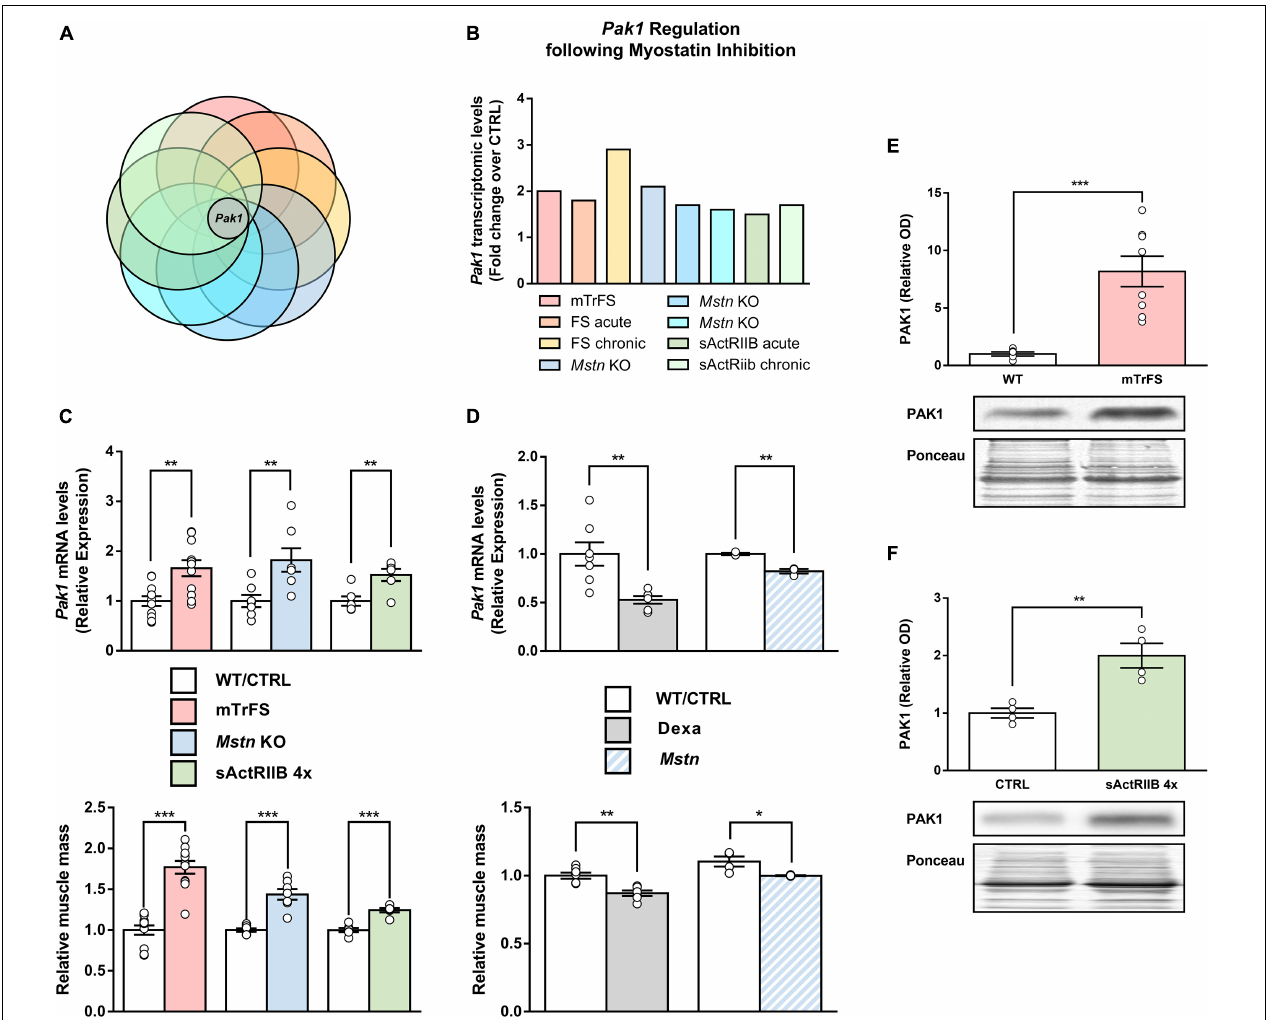
FIGURE 1 | Global comparative transcriptomic analysis of skeletal muscles from mouse models of MSTN inhibition identified Pak1 as a MSTN-responsive gene. (A) Venn diagram comparing the differentially expressed genes into muscles from eight different models of pre- and postnatal MSTN inhibition with Pak1 as the only gene commonly regulated between all the transcriptomes compared. (B) Pak1 mRNA fold-changes for each muscle transcriptome studied. (C) Muscle Pak1 mRNA levels and muscle weight from TA muscles of mTrFS vs. WT mice ( n = 11/group); from TA muscles of four times sActRIIB-injected vs. PBS-injected mice ( n = 6/group) and from GC muscles of MSTN KO vs. WT mice ( n = 7/group). (D) Muscle Pak1 mRNA levels and muscle weight from GC muscles of DEXA-treated vs. saline-treated mice ( n = 7/group) and from MSTN-transfected vs. CTRL pcDNA-transfected TA muscles ( n = 3/group). Representative western blot image and densitometric analysis of PAK1 protein levels in GC muscles from (E) mTrFS vs. WT C57Bl/6 mice ( n = 8/group) and from (F) sActRIIB-injected vs. PBS-injected mice ( n = 4/group). Results are expressed as means ± SEM and statistical analysis was performed using unpaired t -test (* P < 0.05; ** P < 0.01, and *** P < 0.001 vs.